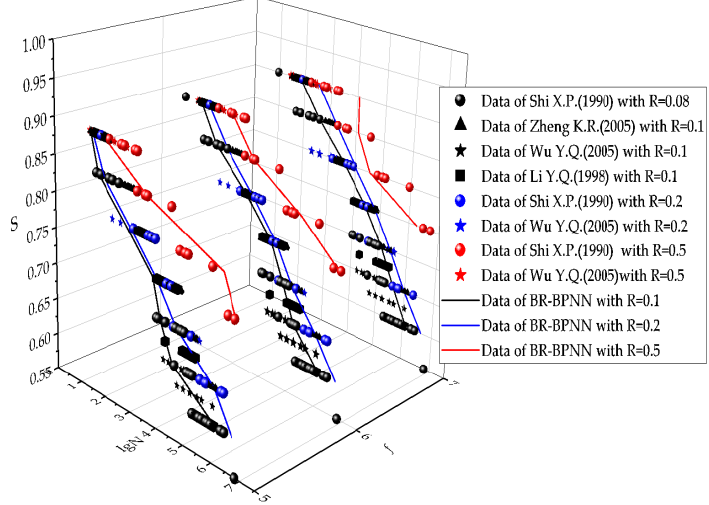
Figure 10. S-N curve under 50% guarantee rate predicted by BR-BPNN.